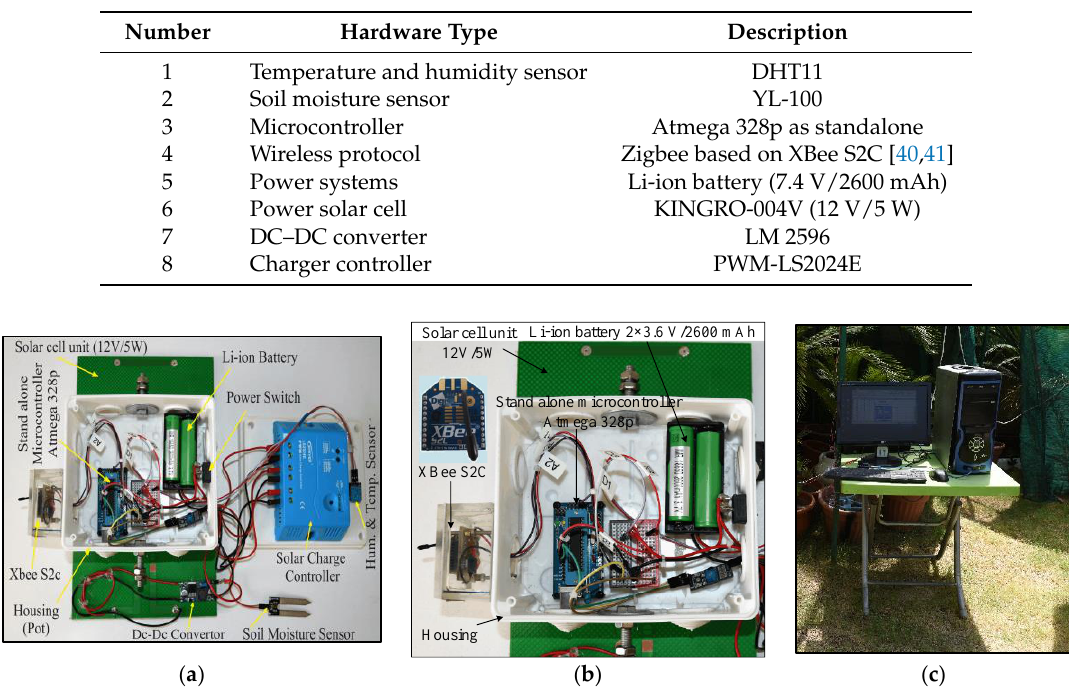
Table 2. Major components of the sensor node for the WAS hardware.